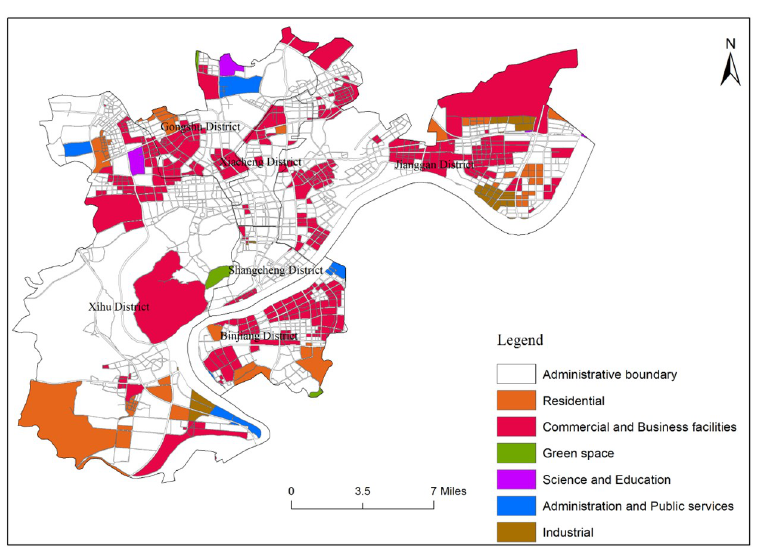
Fig 4. Distribution map of single functional areas in the central city area of